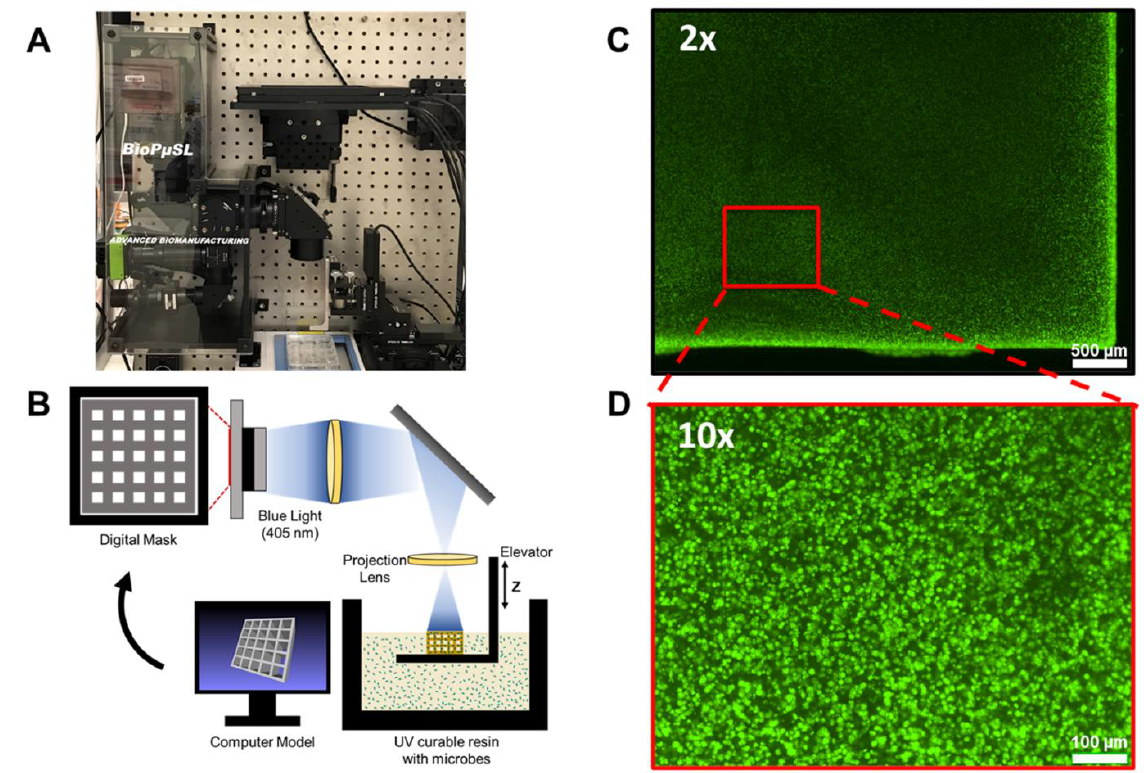
Figure 7. Demonstration of the stereolithographic apparatus for microbial (SLAM) bioprinting. Photograph of the Bio-P µ SL printer used for SLAM printing ( A ). Schematic of the SLAM bioprinting process ( B ). Demonstration of the engineered biofilm using encapsulated E. coli expressing GFP (green) under 2× magnification ( C ) or 10× magnification ( D ). Reproduced with permission from